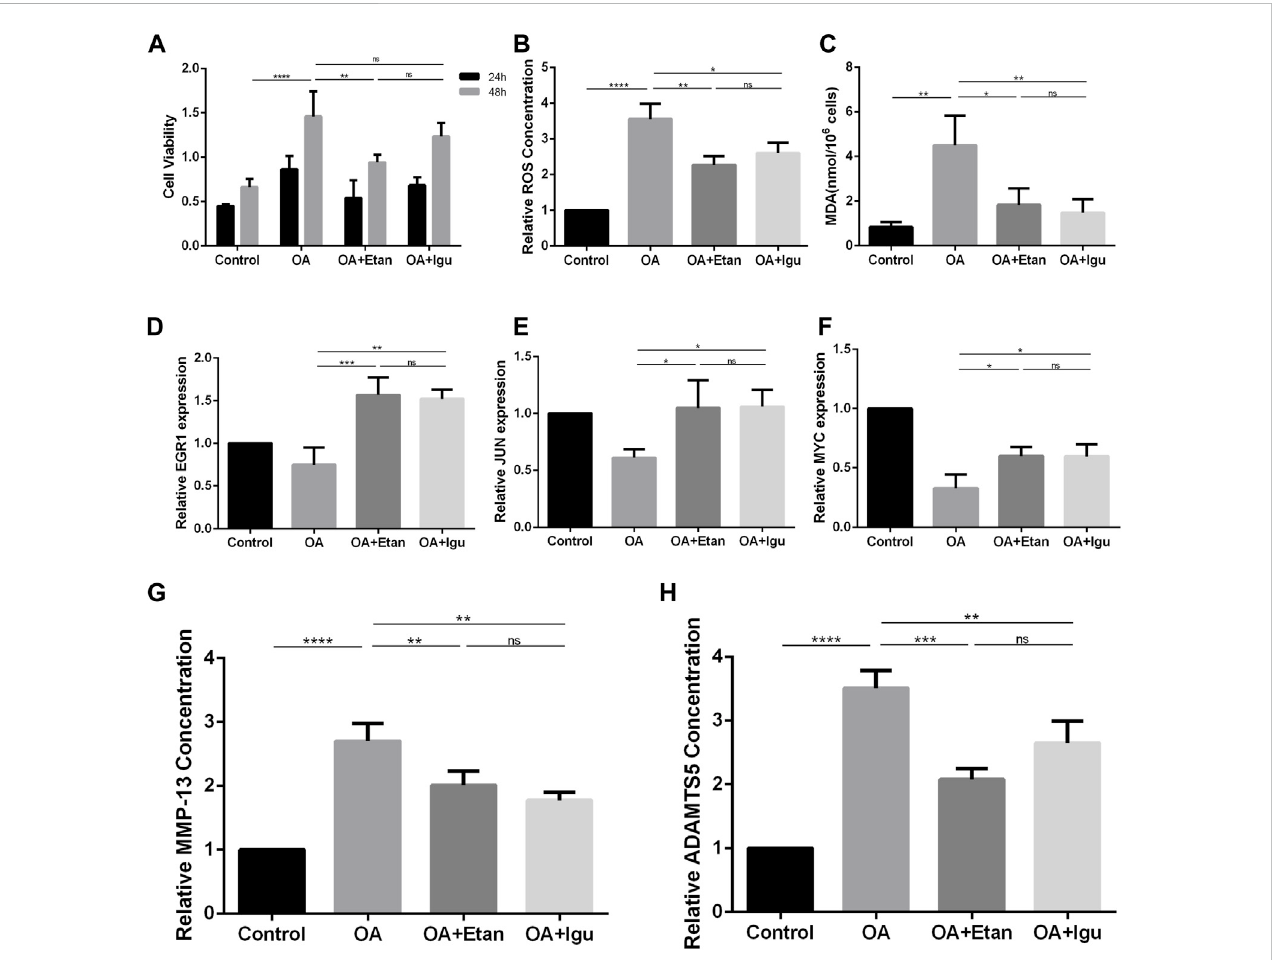
FIGURE 9 Validation of the effect of Etanercept and Iguratimod on FLS. (A) Cell viability of FLS at 24 and 48 h. (B) Relative Intracellular ROS concentration of FLS. (C) MDA concentration of FLS of different groups. (D – F) mRNA expression of EGR1, JUN and MYC of the four groups. (G, H) The level of MMP-13 and ADAMTS5 in the supernatant of FLS in different groups. OA = osteoarthritis; Etan = Etanercept; Igu = Iguratimod; ROS = reactive oxygen species; MDA = Malonic dialdehyde; MMP-13 = matrix metalloproteinase 13; ADAMTS5 = a disintegrin and metalloproteinase with thrombospondin motifs-5. * p < 0.05, ** p < 0.01, *** p < 0.001, **** p < 0.0001. Error bars represent